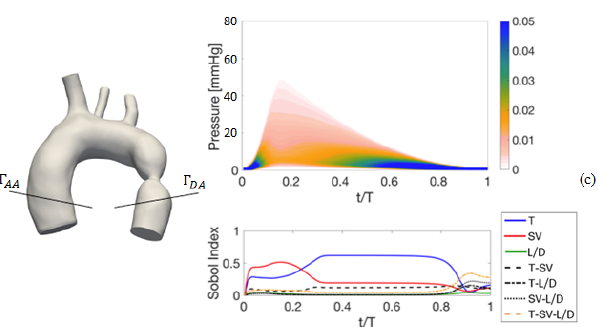
Figure 16. PDF of the ∆ p waveforms between Γ AA and Γ DA (top panel) and relative Sobol indexes (bottom panel): ( a ) healthy aorta, ( b ) aorta with aneurysm, and ( c ) aorta with